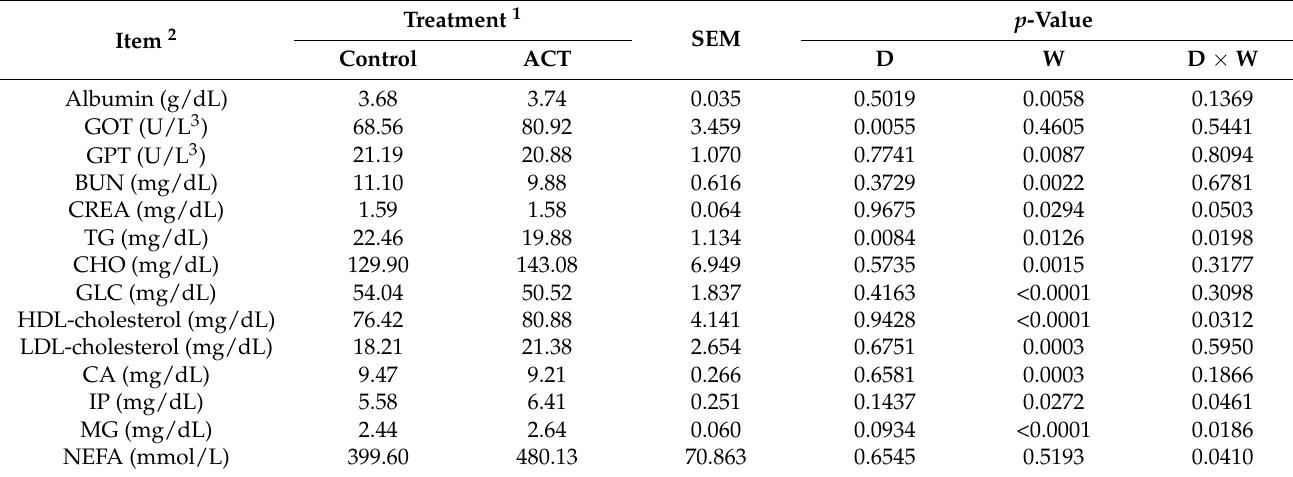
Table 8. Serum metabolic profile of cows